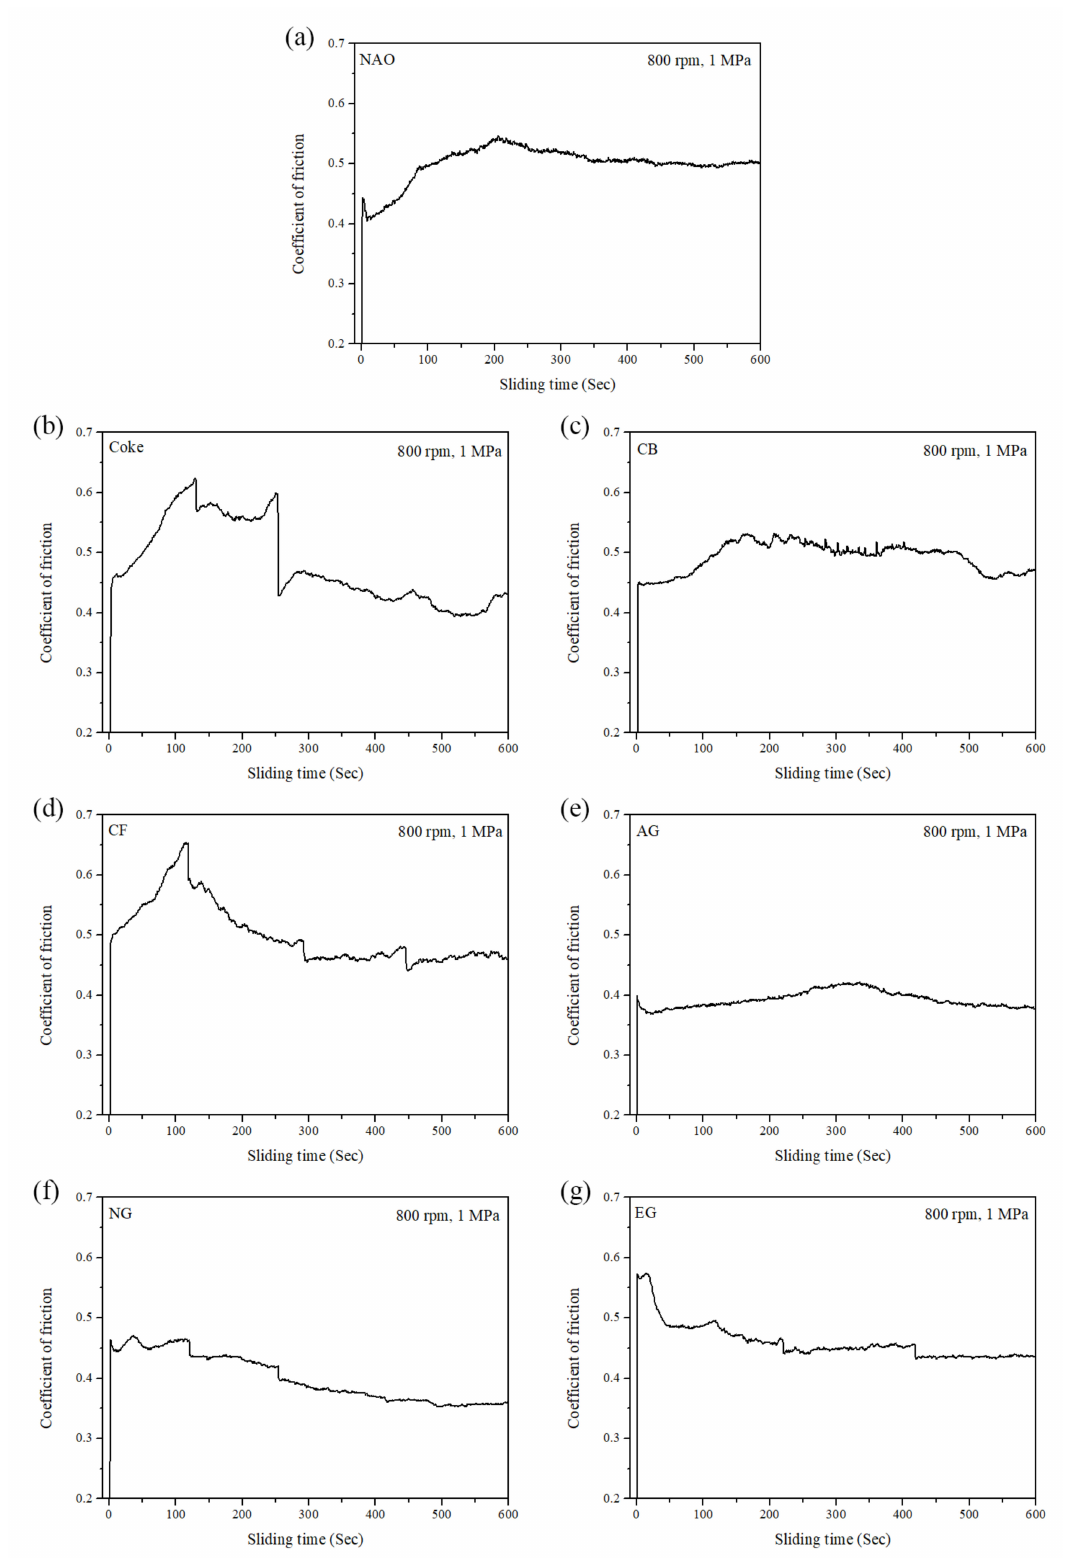
Figure 5. The COF curves of specimens: ( a ) NAO, ( b ) Coke, ( c ) CB, ( d ) CF, ( e ) AG, ( f ) NG, ( g )